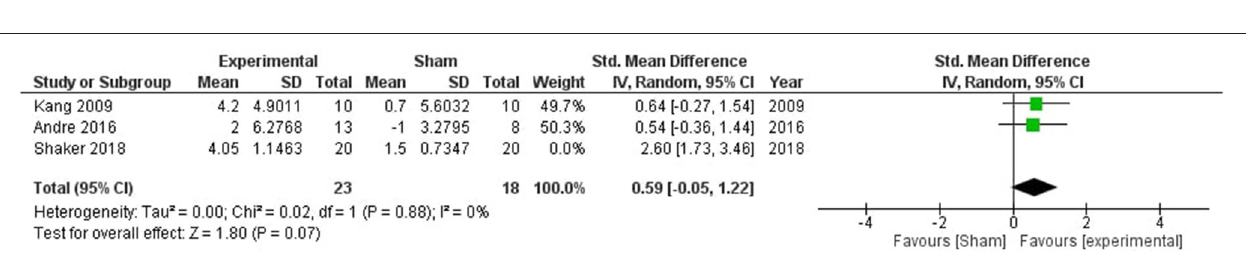
FIGURE 3 | Comparison of the effects of active transcranial stimulation and sham stimulation interventions on attention. One study was excluded after sensitivity analysis. The results favored the efficacy of stimulation in facilitating attentive abilities (SMD = 0.59, CI = − 0.05–1.22, p =